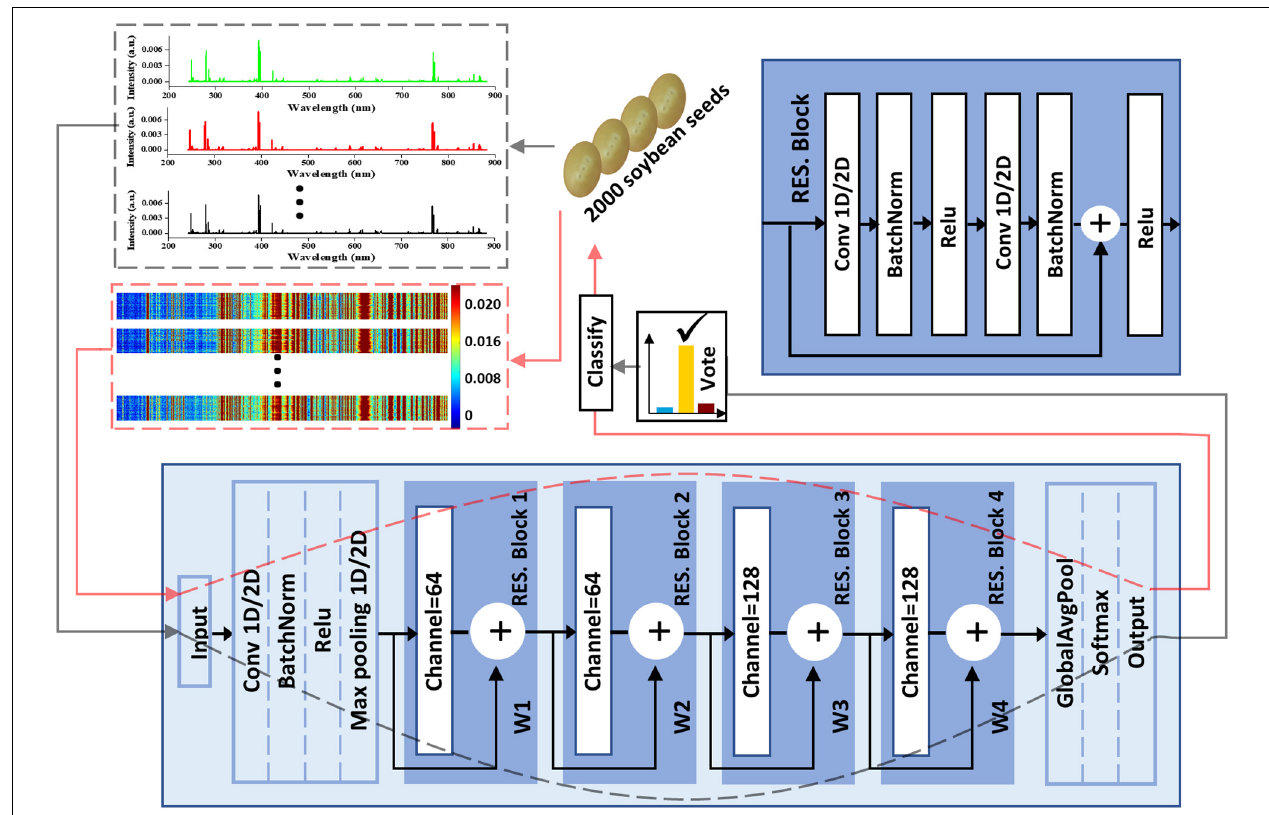
FIGURE 2 | The soybean seeds classification flowchart including data input, ResNet-based classifier, and a majority vote strategy.